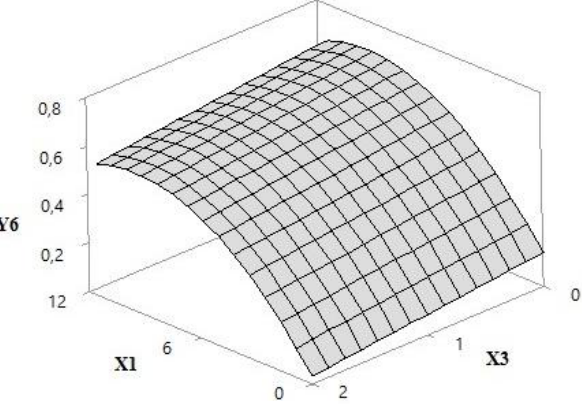
Figure 9. Response surface 3D plot of UVA / UVB ratio (Y6) as a function of the concentration of UV filters: butyl methoxydibenzoyl methane — UVA, ethylhexyl methoxycinnamate — UVB and ethylhexyl dimethyl PABA — UVB of 0 – 12% w / w (X1) and irradiation time of 1 – 2 h (X3).